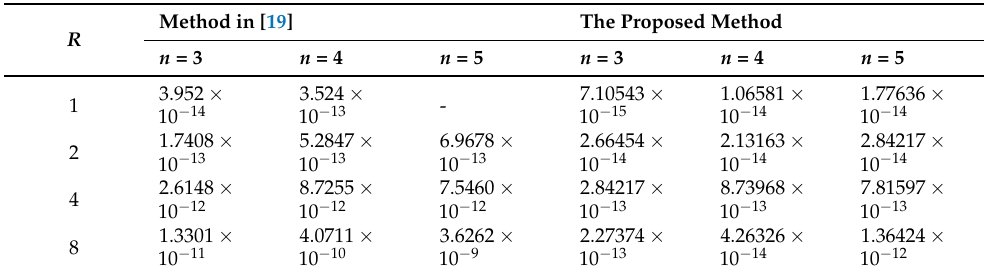
Table 4. Error ε of Example 3 for different R